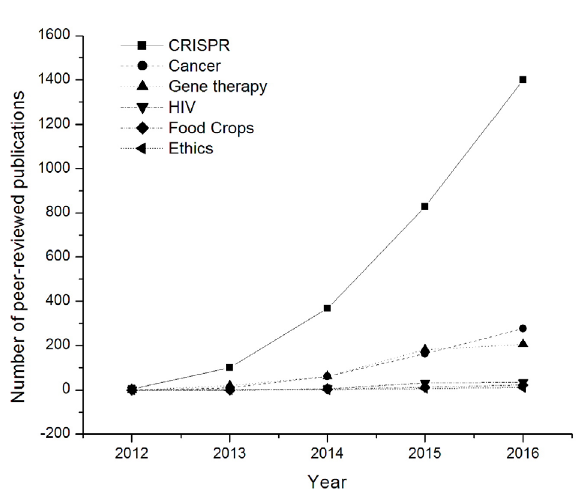
Figure 2: Since the discovery of the CRISPR/Cas9 system in 2012, genome editing has become an intense field of research; this is evident after reviewing the increment in publications involving this technology in recent years. The data shows the number of publica- tions in 5 different fields where CRISPR/Cas9 was involved; research on disease being the most sought application of CRISPR/Cas9. The search was performed using PubMed, data was retrieved between November 28 th and December 5 of 2016. Key words included CRISPR, and the combination of CRISPR plus cancer/gene